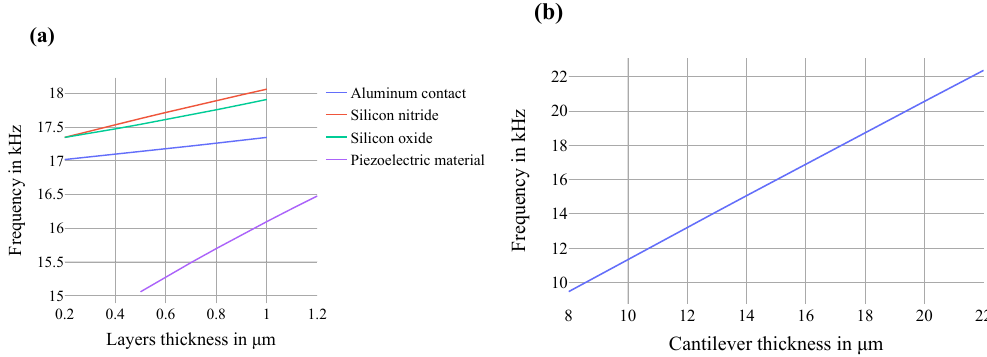
Figure 8. ( a ) Resonance frequencies versus cantilever beam width, showing the width does not affect the first mode between 500–7000µm. ( b ) Resonance frequencies versus cantilever beam length, showing the length has a strong effect between 1000–2000µm.